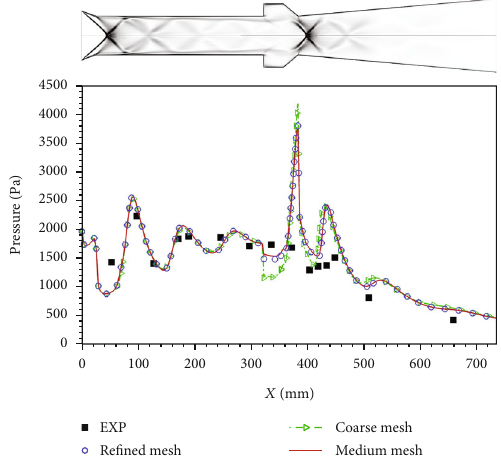
Figure 2: Comparison of wall pressure between experimental [23] and numerical results with di ff erent meshes; the gray contour is the numerical Schlieren to show the fl ow structure and illustrate the variation of the wall re fl ect the characteristics of the axisymmetric scramjet fl ow fi eld.